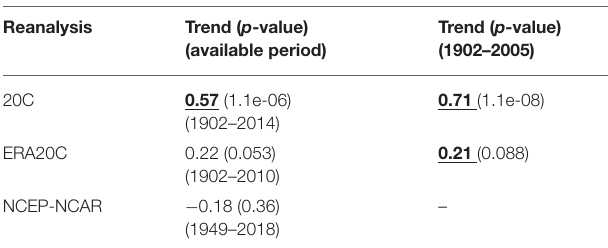
TABLE 1 | Linear trends of U200 anomalies computed from the three reanalysis